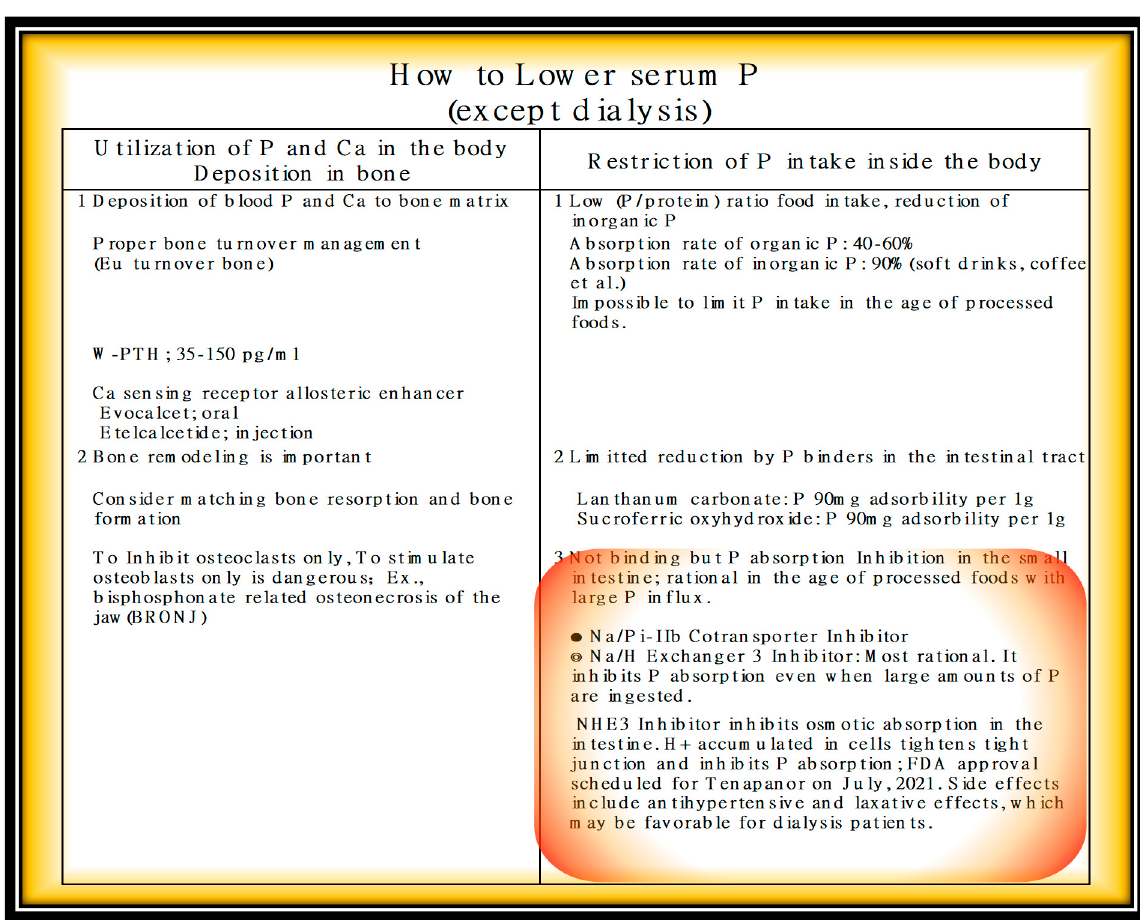
Figure 11. The mechanism of NaHE 3 Inhibitor. NaHE 3 Inhibitor; sodium hydrogen exchanger inhibitor.